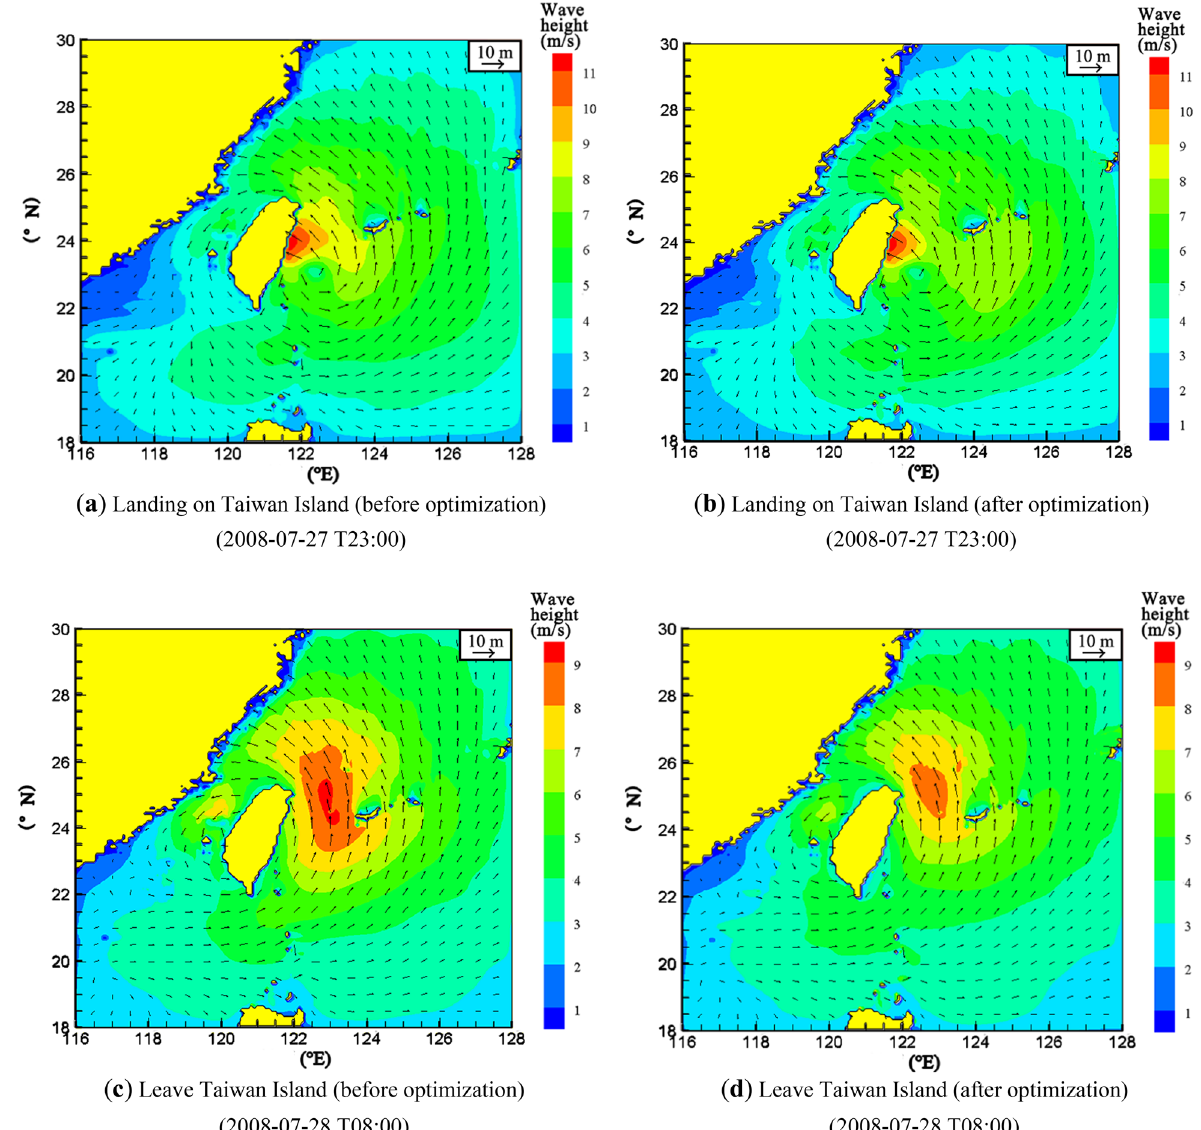
Fig. 9 The distribution of wind speed and significant wave height before and after optimization of typhoon fung-wong when it landed (2008-07-28T06:00) and left Taiwan